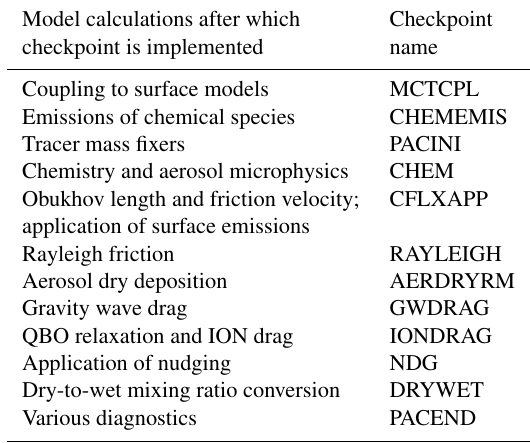
Table B2. Checkpoints in the parameterization suite calculated after coupling with surface models, i.e., in the tphysac subroutine. The order of checkpoints in the table is the same as the actual order of the checkpoints in the code.